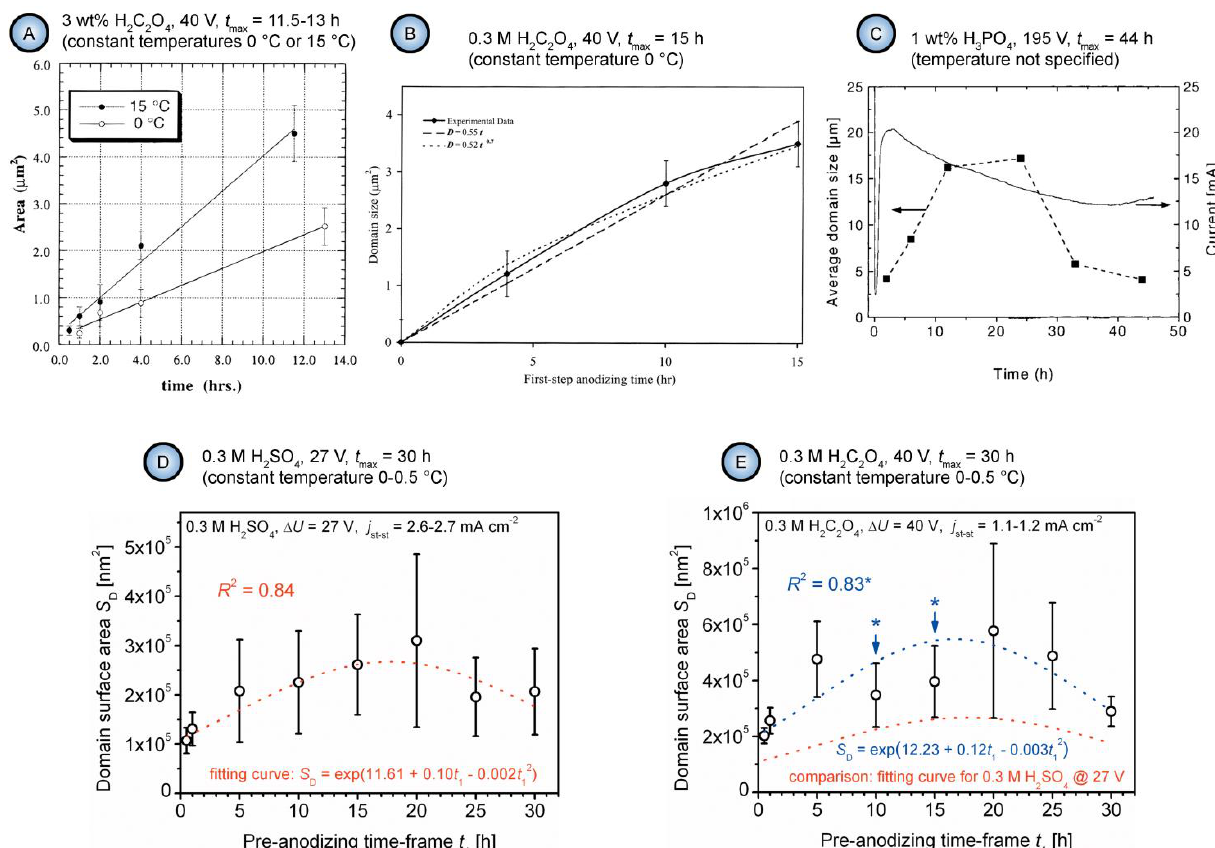
Figure 9. Several examples illustrating the time evolution of the average size of hexagonally ordered pore domains during long-term potentiostatic anodizing of aluminum in different electrolyte solutions. ( A ) A linear relationship reported by Li et al. for the 11.5–13 h long experiments performed in 3 wt % H 2 C 2 O 4 at 40 V [91]; ( B ) The slope of the curve obtained for H 2 C 2 O 4 solution visibly begins to decrease if the experiment duration is prolonged to 15 h [100]; ( C ) Anodizing over an extended 48 h time period using 1 wt % H 3 PO 4 reveals the presence of a critical point in time after which the well-ordered domain size begins to systematically decrease [92]; ( D , E ) A combined study of H 2 C 2 O 4 and H 2 SO 4 electrolyte solutions has demonstrated that the evolutionary trend reverses after reaching some critical point in time (at approximately 20 h) irrespective of the employed type of electrolyte [30]. Reproduced with permissions. Copyright 1998, 2002 and 2020 American Chemical Society, 2006 Elsevier.